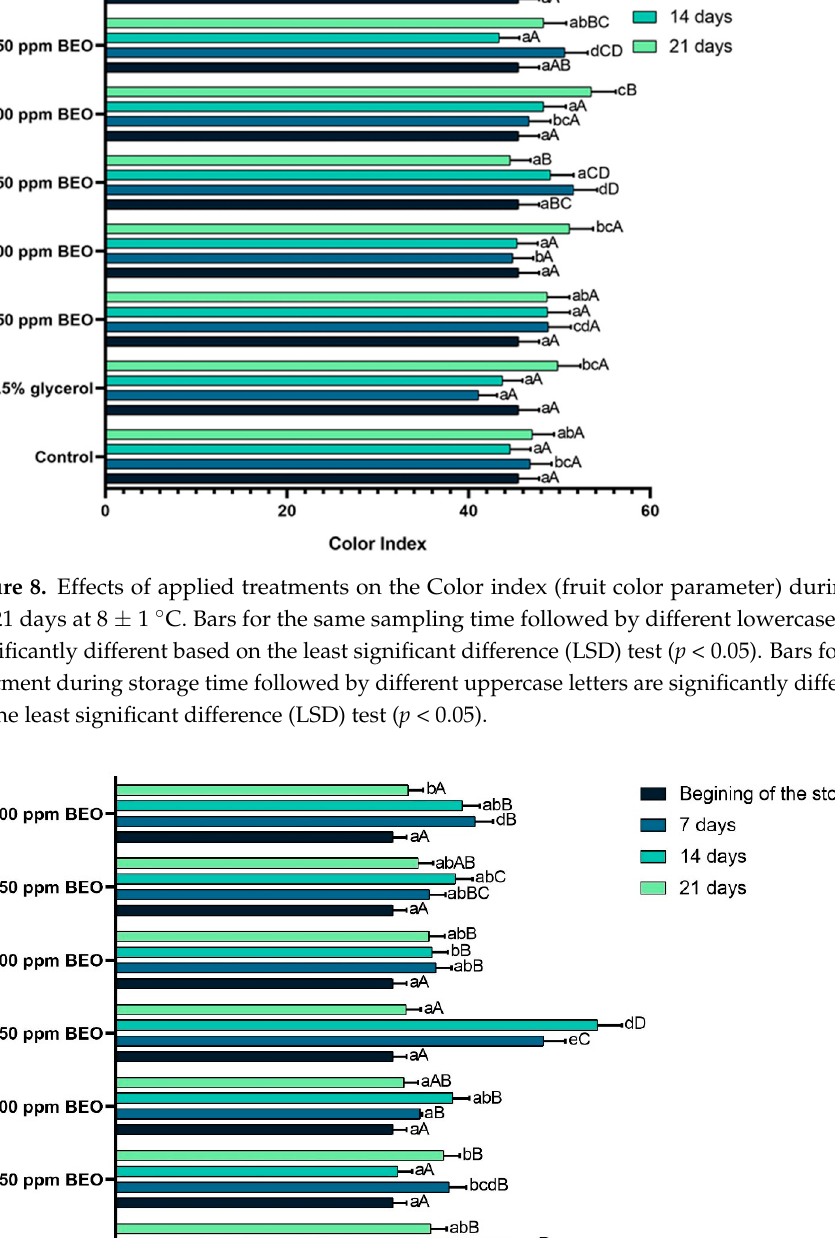
Figure 7. Effects of applied treatments on the Lightness (fruit color parameter) during storage for 21 days at 8 ± 1 °C. Bars for the same sampling time followed by different lowercase letters are signifi- cantly different based on the least significant difference (LSD) test ( p < 0.05). Bars for the same treat- ment during storage time followed by different uppercase letters are significantly different based on the least significant difference (LSD) test ( p < 0.05).